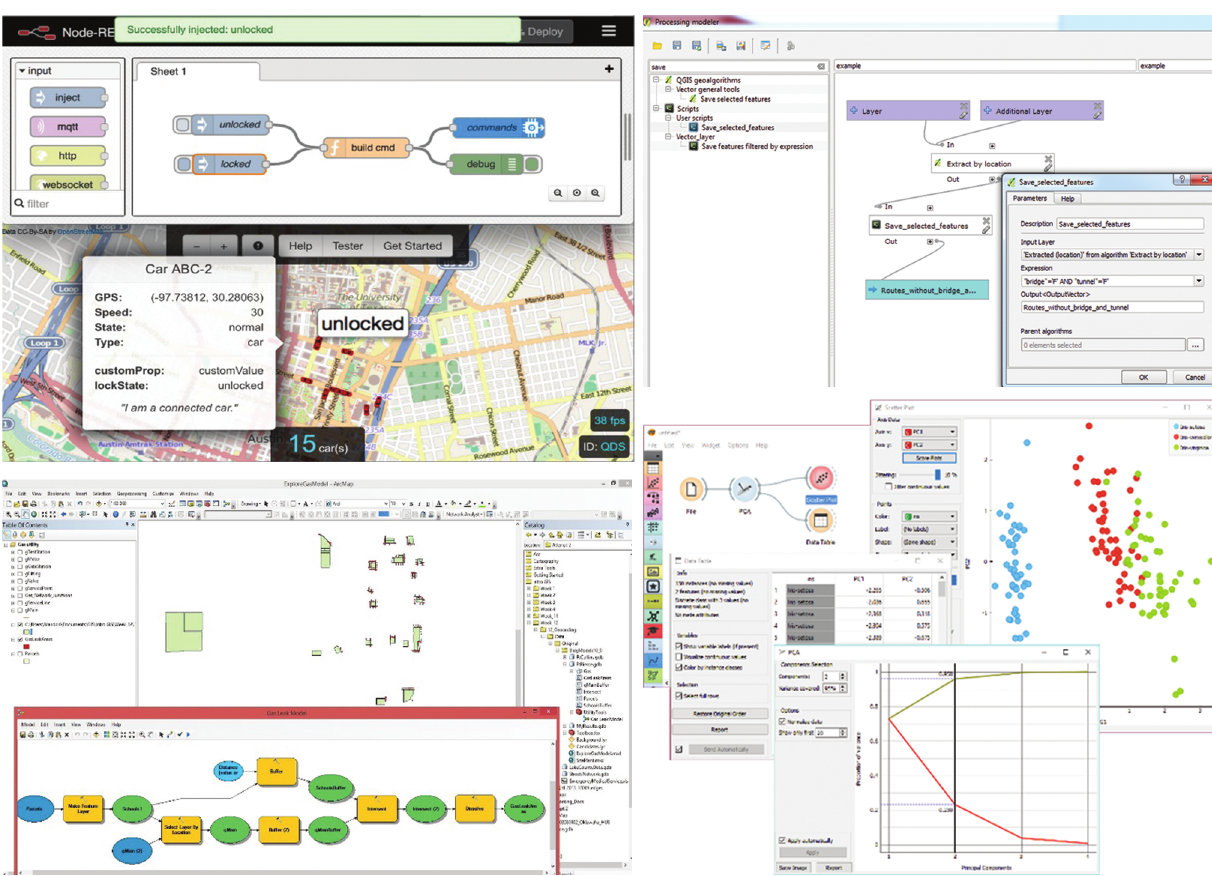
Figure 2. Data processing workflow examples, respectively from top left, clockwise, node-RED, editable by JavaScript (pic- ture from Boyd, 2015), QGIS Graphical Modeller 8 , Anaconda Orange3 9 , and ArcGIS Model Builder 10 , all of which offer Python APIs. The GIS dataflow programming environments make it easy to automate routines, share them, and use stan- dard modules; however, the installation procedures, their domain specific nature and their UI make them much less ac- cessible than the two all-purpose data-flow programming environments